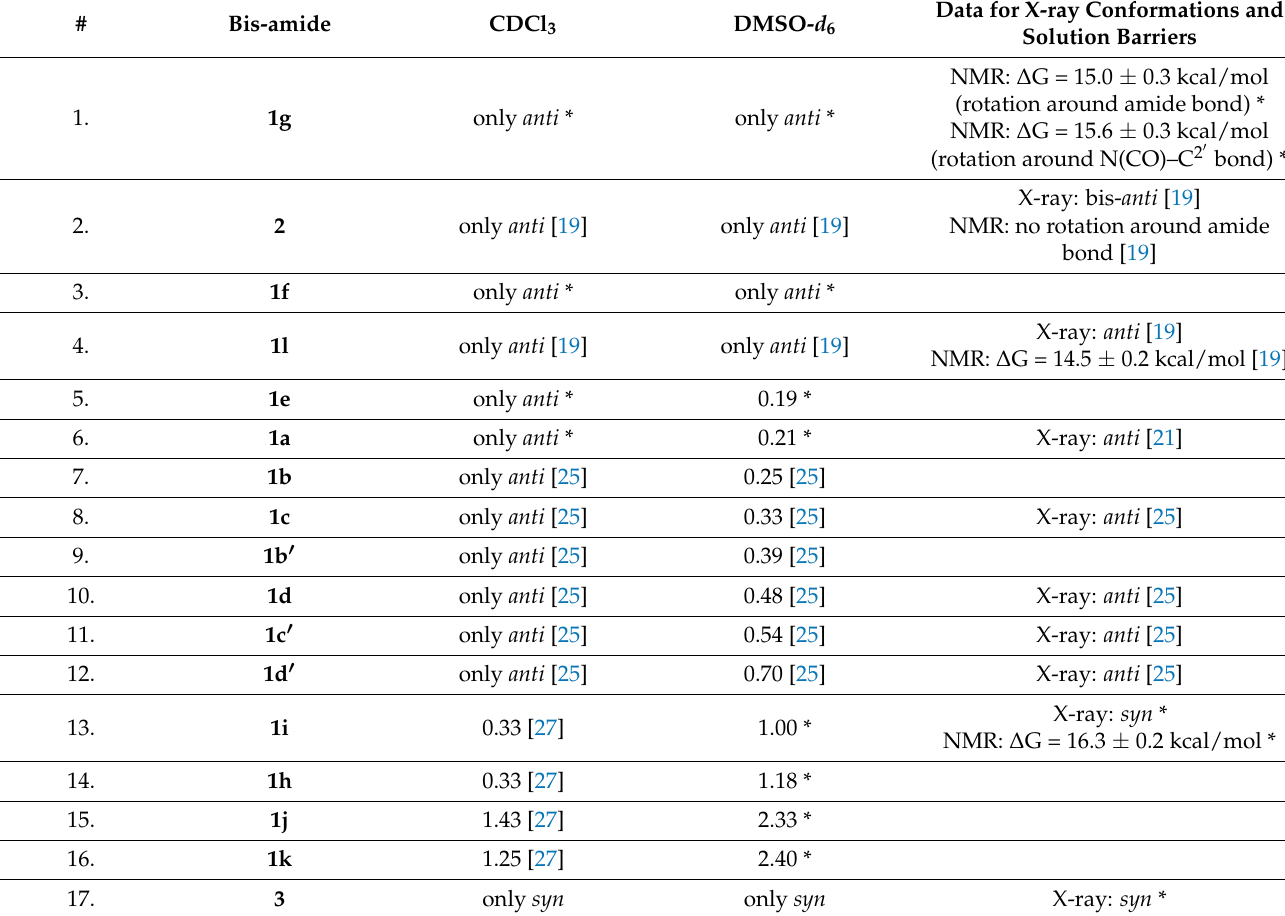
Table 1. Syn / anti ratios for bis-amides 1a – 1l , 2 , and 3 in CDCl 3 and DMSO- d 6 . Data are in ascending order of the syn -form in DMSO- d 6